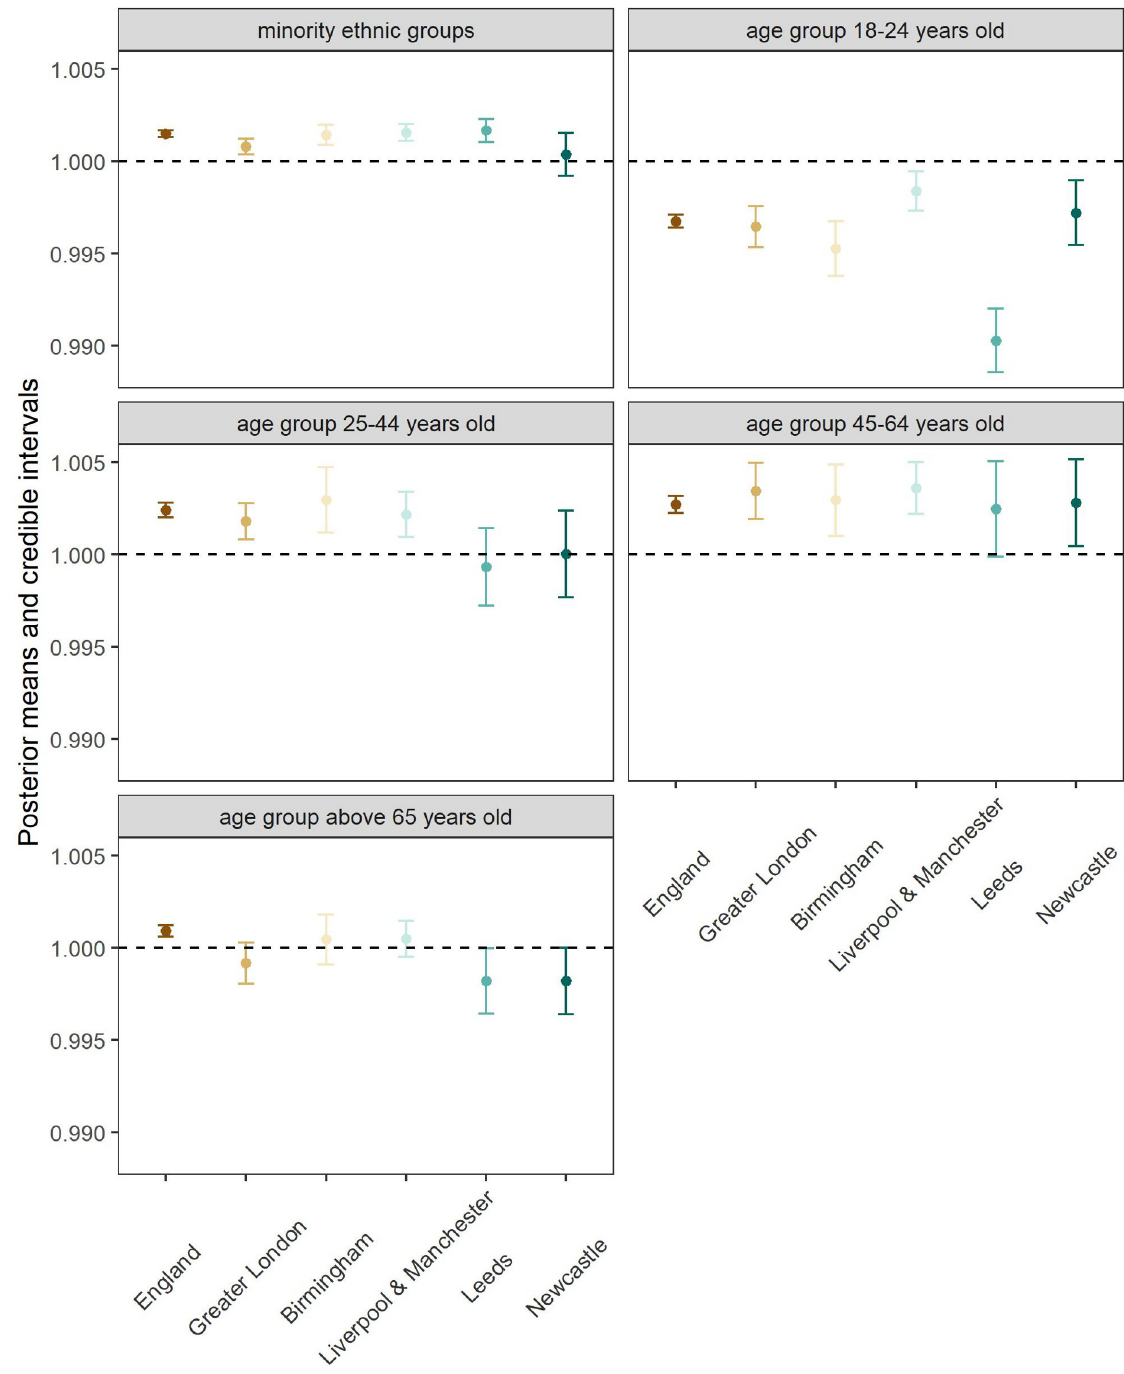
Fig 2. Posterior estimates (posterior mean and 95% credible interval represented by the dot and the vertical interval, respectively) of the PR of the socioeconomic variables on mean SMI prevalence estimated from the full model. For all 5 covariates, the estimated covariate effect greater than 1 suggests an LSOA with a larger covariate value (e.g., a higher percentage of minority ethnic groups) was associated with a higher SMI prevalence. An estimate with its 95% CI excluding 1 indicates a high certainty that a covariate-outcome association exists. LSOA, Lower Layer Super Output Area; PR, prevalence ratio; SMI, serious mental illness.